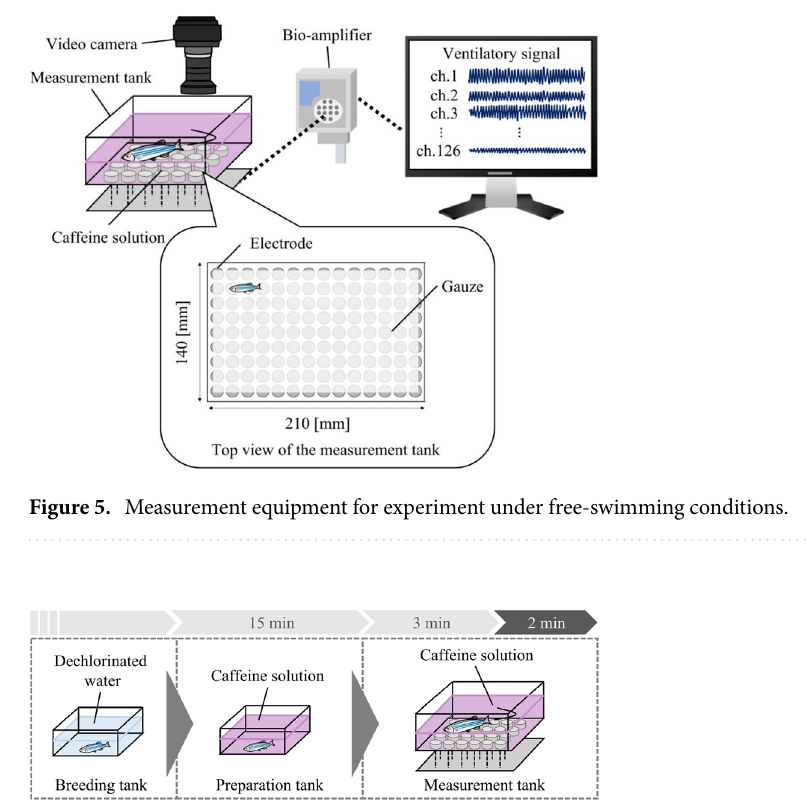
Figure 6. Experimental protocol for the free-swimming